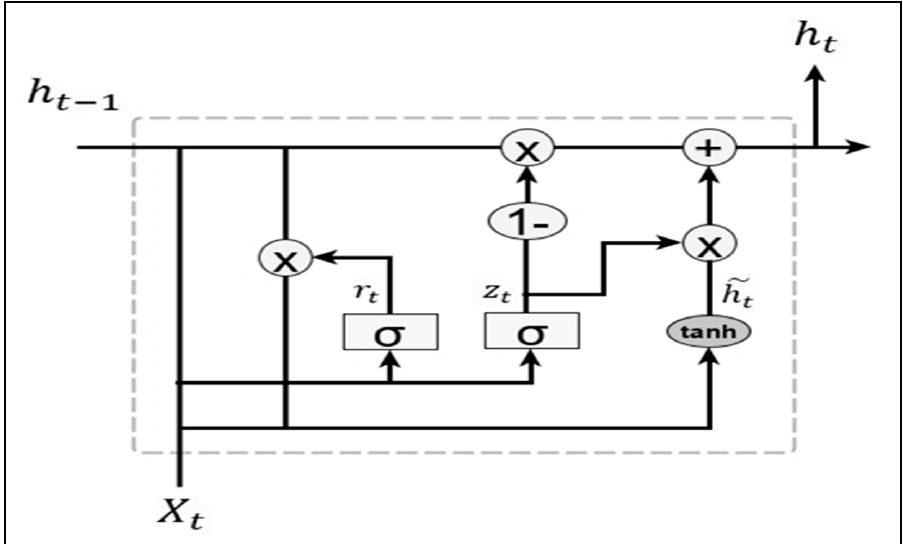
Figure 4. Architecture of GRU.